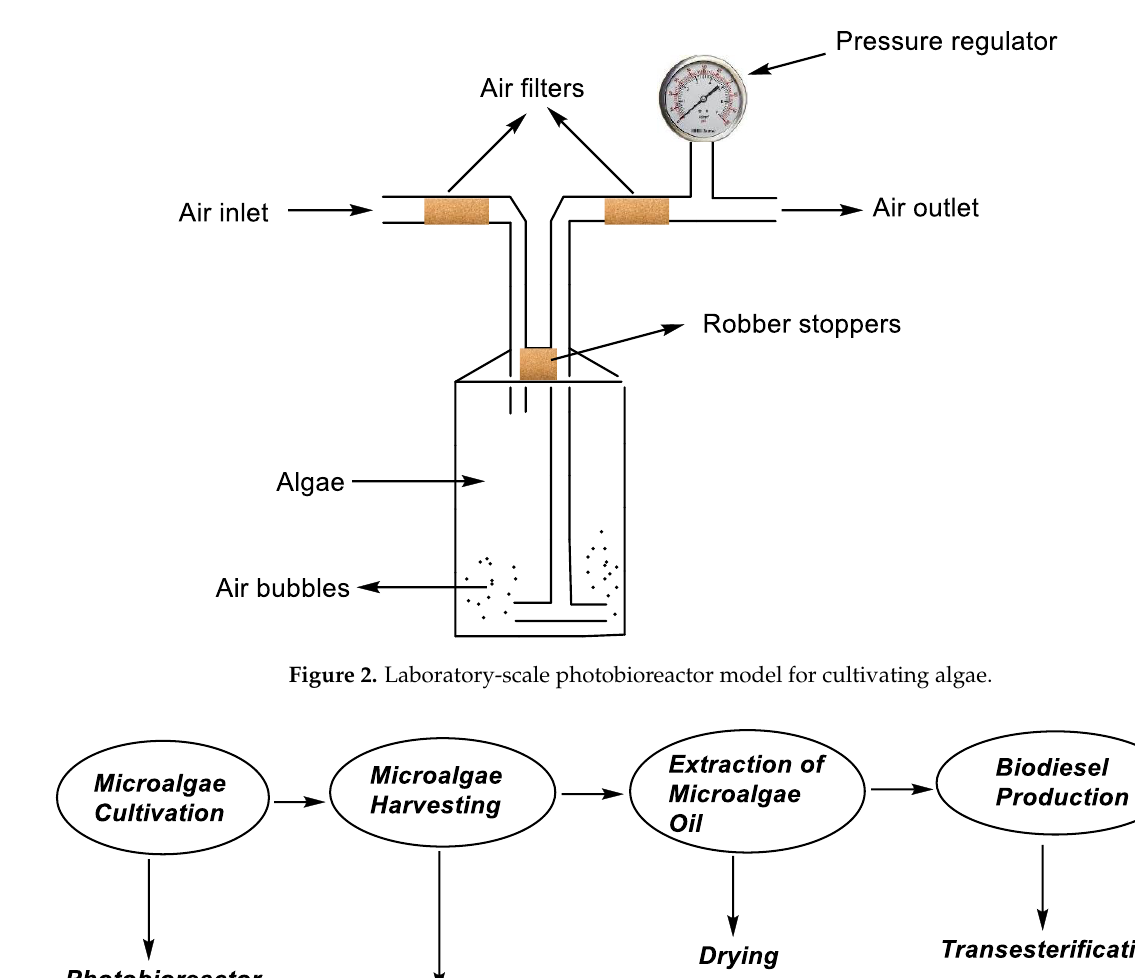
Table 3. Comparison of cultivation process for microalgae oil production of some selected species of microalgae reported in literature.